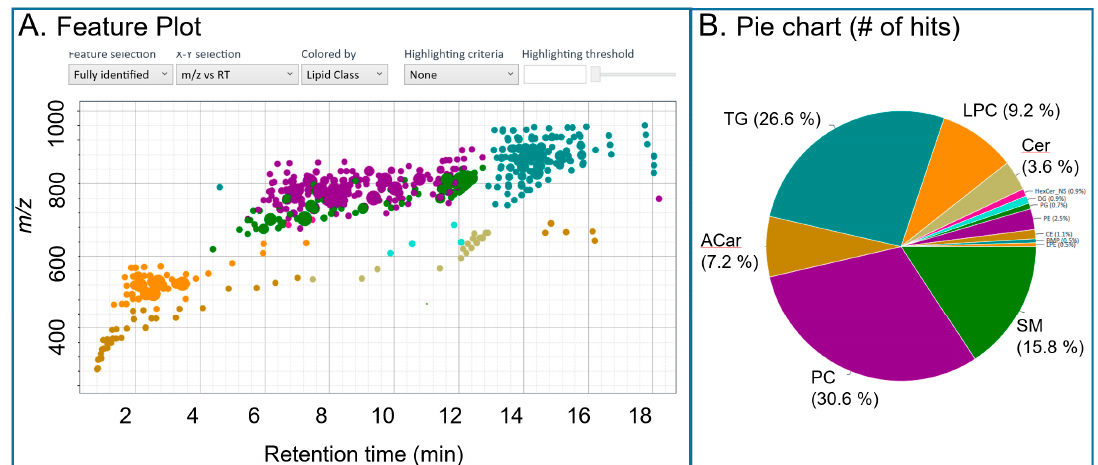
Figure 4. Examples of Lipid Annotator data-visualizations (feature view) for NIST SRM1950 in positive ion mode. Panel ( A ) shows a plots of features which can be used to examine patterns across retention time, mobility, lipid class, identified versus non-identified compounds, Q-score (chromatographic peak quality) and abundance. In panel ( B ) a pie chart displays the total number of annotated lipids per lipid class Note that axis and labels were re-written in larger font to be able to be read in a publication sized figure. Acronyms are defined in Appendix B.